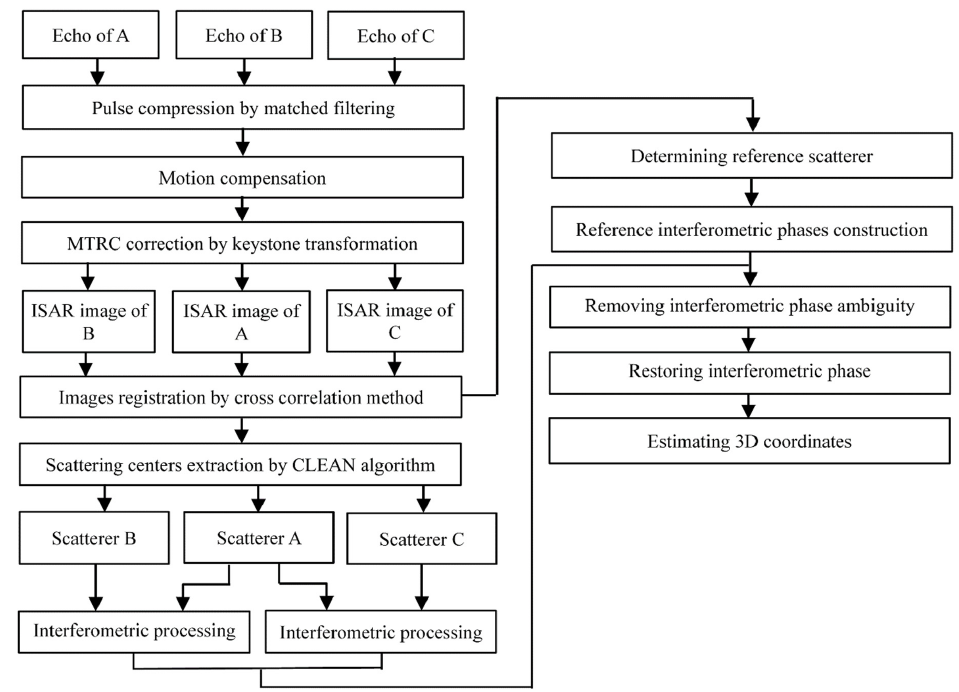
Figure 4. Flowchart of the proposed InISAR imaging method.